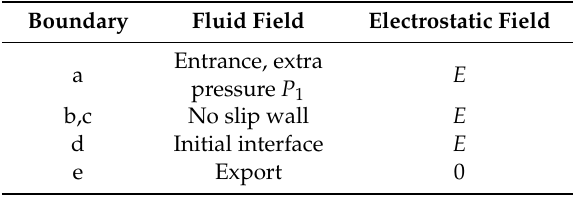
Figure 6. Geometric size and the boundary conditions of the model. Table 1. Boundary conditions of the model.